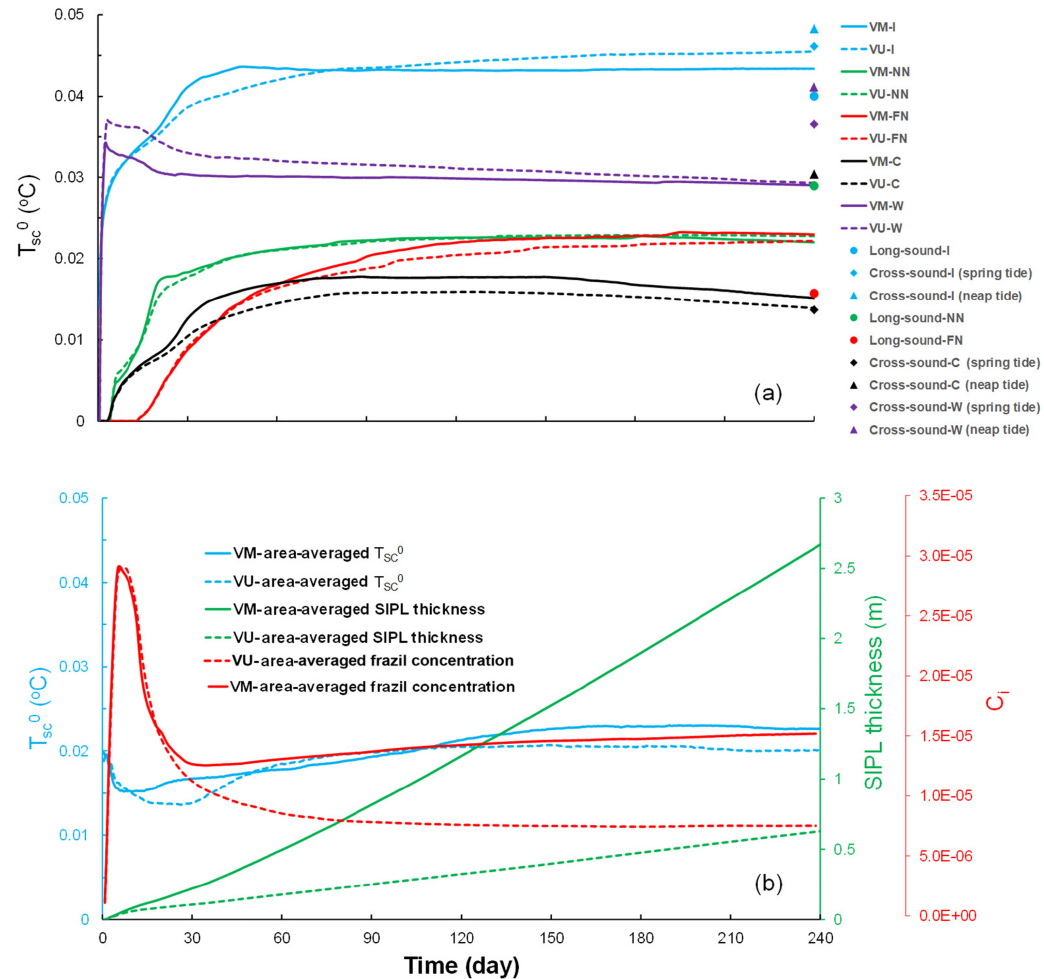
Figure 4. (a) Time series of T 0 simulated by VM (solid lines) and VU (dashed lines) models at five oceanographic sites (colour coded) in SC the McMurdo Sound region. (b) Time series of area-averaged T 0 (blue), SIPL thickness (green), and frazil concentration (red) simulated SC by VM (solid lines) and VU (dashed lines) models over the model domain (purple frame in Fig.